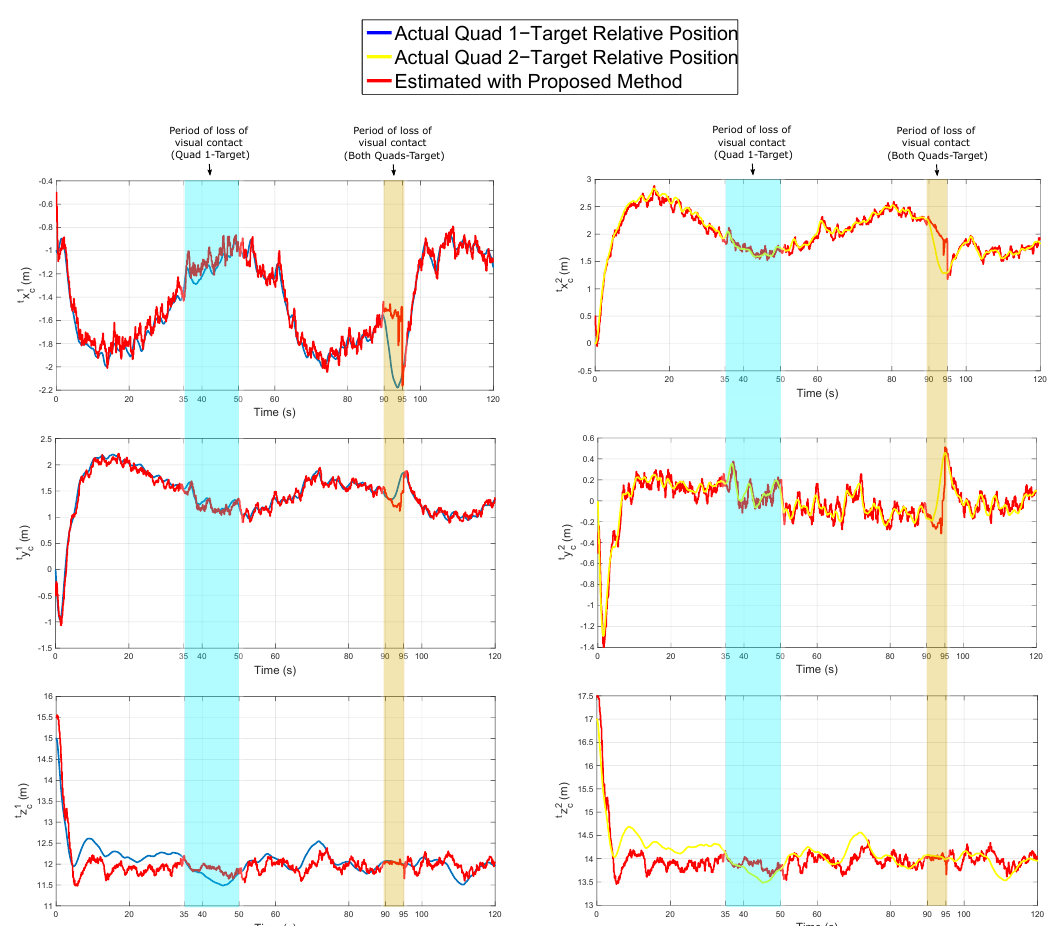
Figure 12. The estimated relative position of Quad 1 and Quad 2 with respect to the